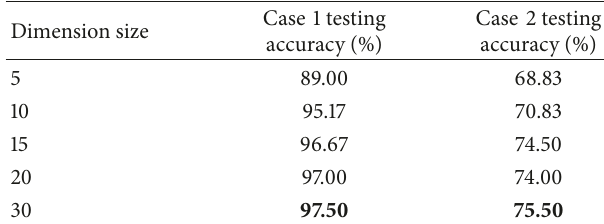
Table 15: Bearing fault diagnosis results obtained by the OFS-PCA- SVM.